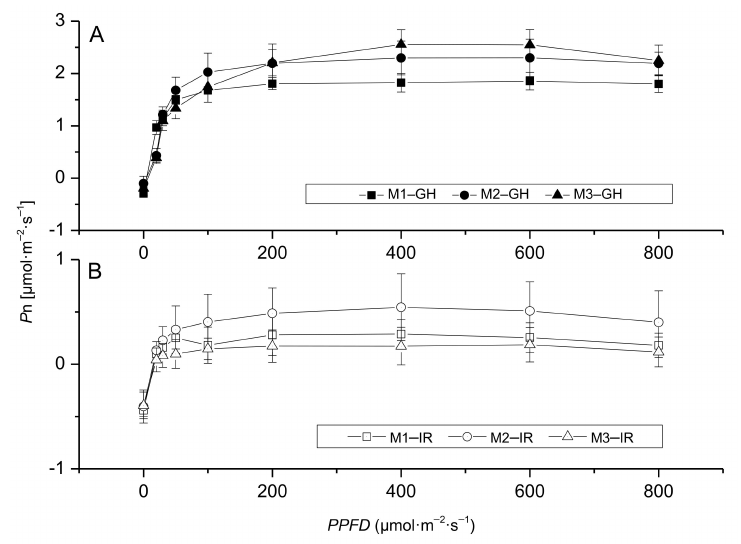
Figure 4. Response of net photosynthetic rate of Anthurium × ‘Red’ grown under a medium light level (350 µ mol · m − 2 · s − 1 ) before ( A ) and after ( B ) placement to interior rooms. Where M: medium light level, IR: interior room, and numeric values 1, 2, and 3 represent the bottom old leaf, center mature leaf, and the top young expanded leaf, respectively.